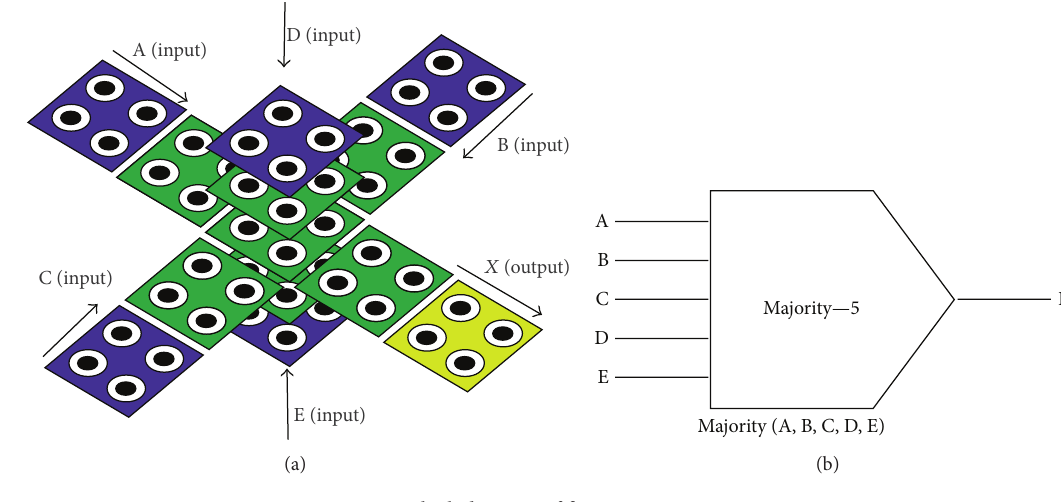
Figure 3: Block diagram of five-input majority gate.